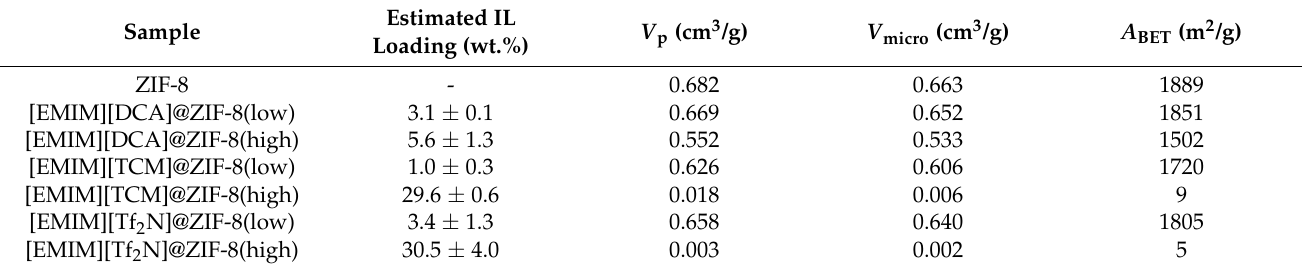
Table 1. Estimated IL mass loading for the produced IL@ZIF-8 composites. BET surface area and porous volume obtained from N 2 isotherms at 77 K for ZIF-8 and composites. Estimated IL Sample Loading